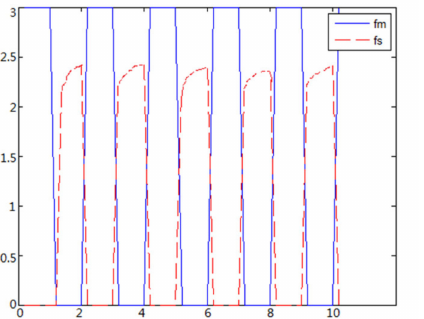
Figure 18. Force feedback along x axis. (Constant time delay, elastic